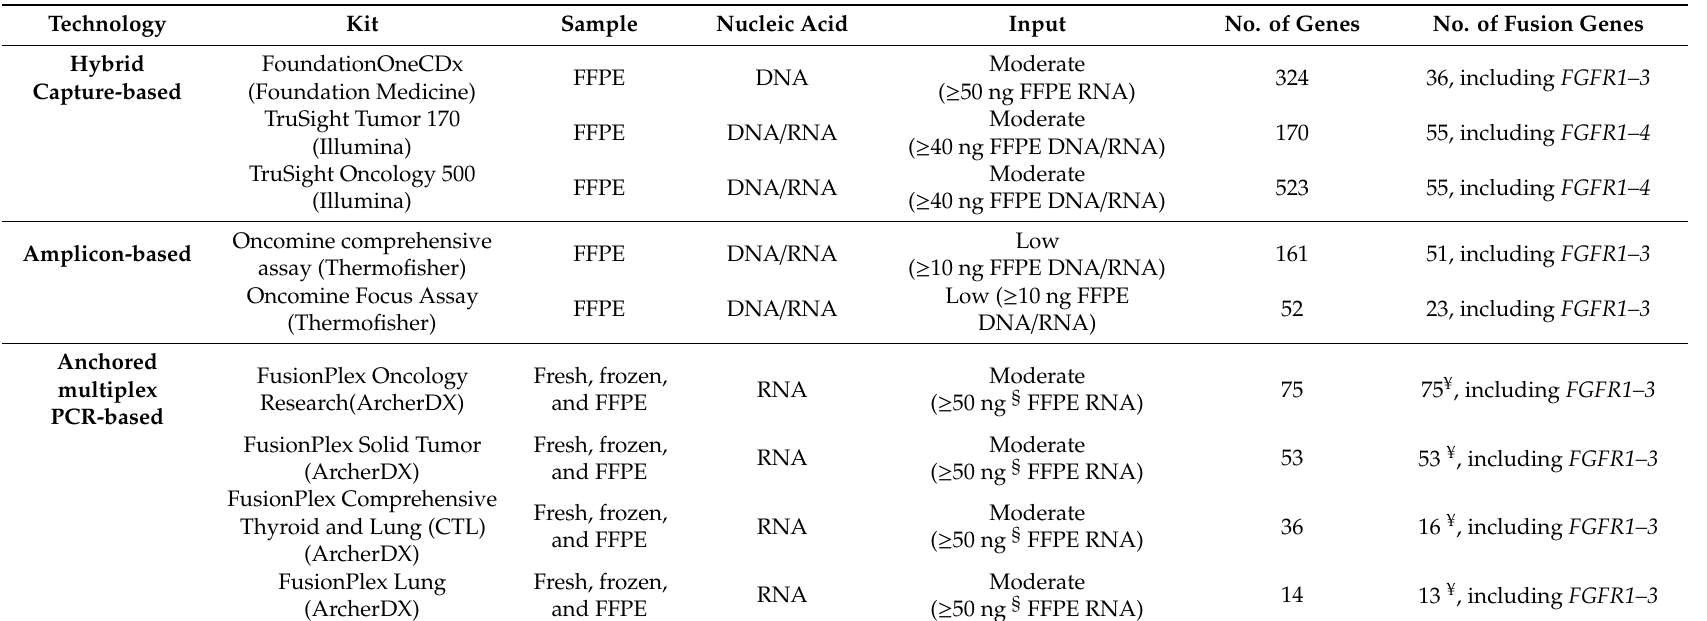
Table 2. Commercially available targeted sequencing kits for fusion